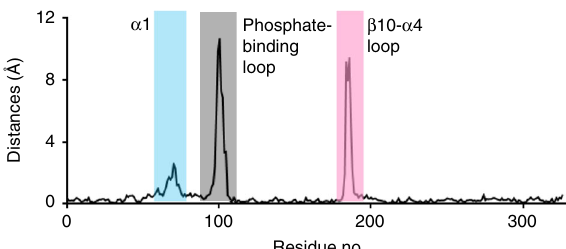
(Fig. 5e, right), the side-chain orientation of S191 in the closed conformation (MDD EF -MVAPP-ADPBeF 3 -Mg 2 + ) changes to interact with conserved K187, resulting in loss of contacts with MVAPP. In summary, the angular changes in helix α 1, α 2, and α 4 are consistent with the dynamic interactions between key residues and ligands (Supplementary Tables 4 and 5). These differences in the apo and ligand-bound MDD EF structures here reveal a coordinated set of programmed conformational rearrangements around the active site region upon each step of substrate binding during the catalytic reaction.